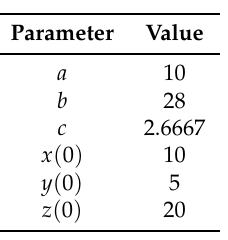
Table 1. Parameter values of the Lorenz